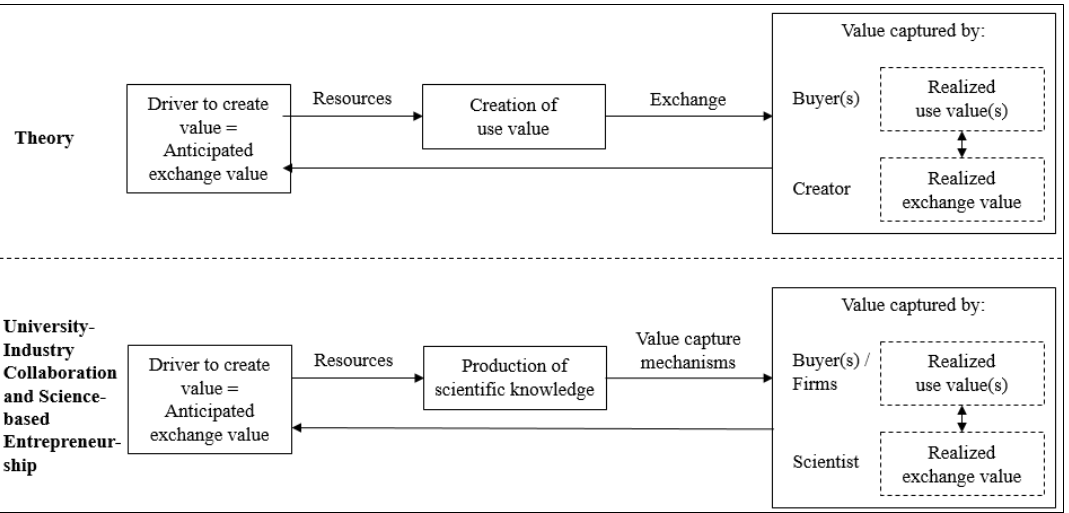
Figure 1. Graphical summary of the process of value creation and value capture in general and from scientific knowledge. Source: own illustration adapted from Bowman and Ambrosini (2000) [2].